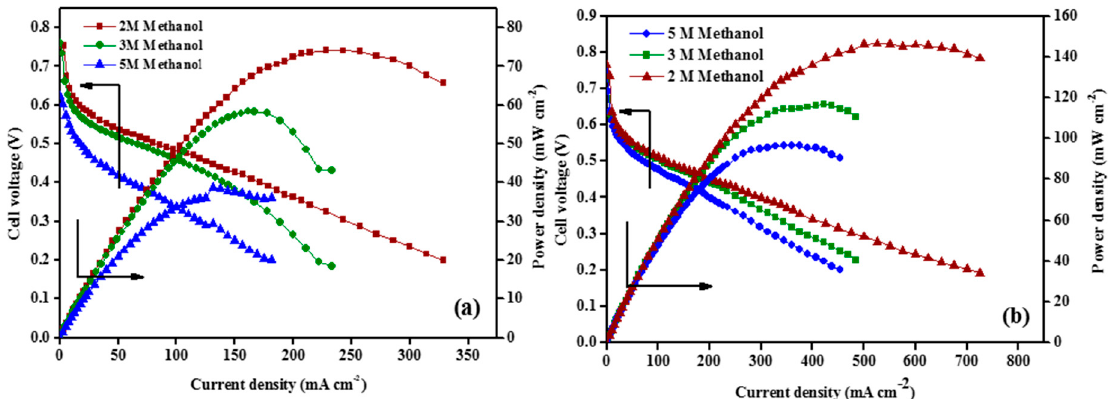
Figure 18. DMFC polarization for ( a ) recast Nafion ® and ( b ) Nafion ® -FF (1 wt.%) at different methanol concentrations at 60 °C (anode: Pt-Ru/C, 2 mg cm − 2 and cathode: Pt/C, 2 mg cm − 2 . Anode fuel: 2 M methanol 2 mL min − 1 , cathode: oxygen 300 mL min − 1 ). Reproduced from [77], with permission from Elsevier, 2016.